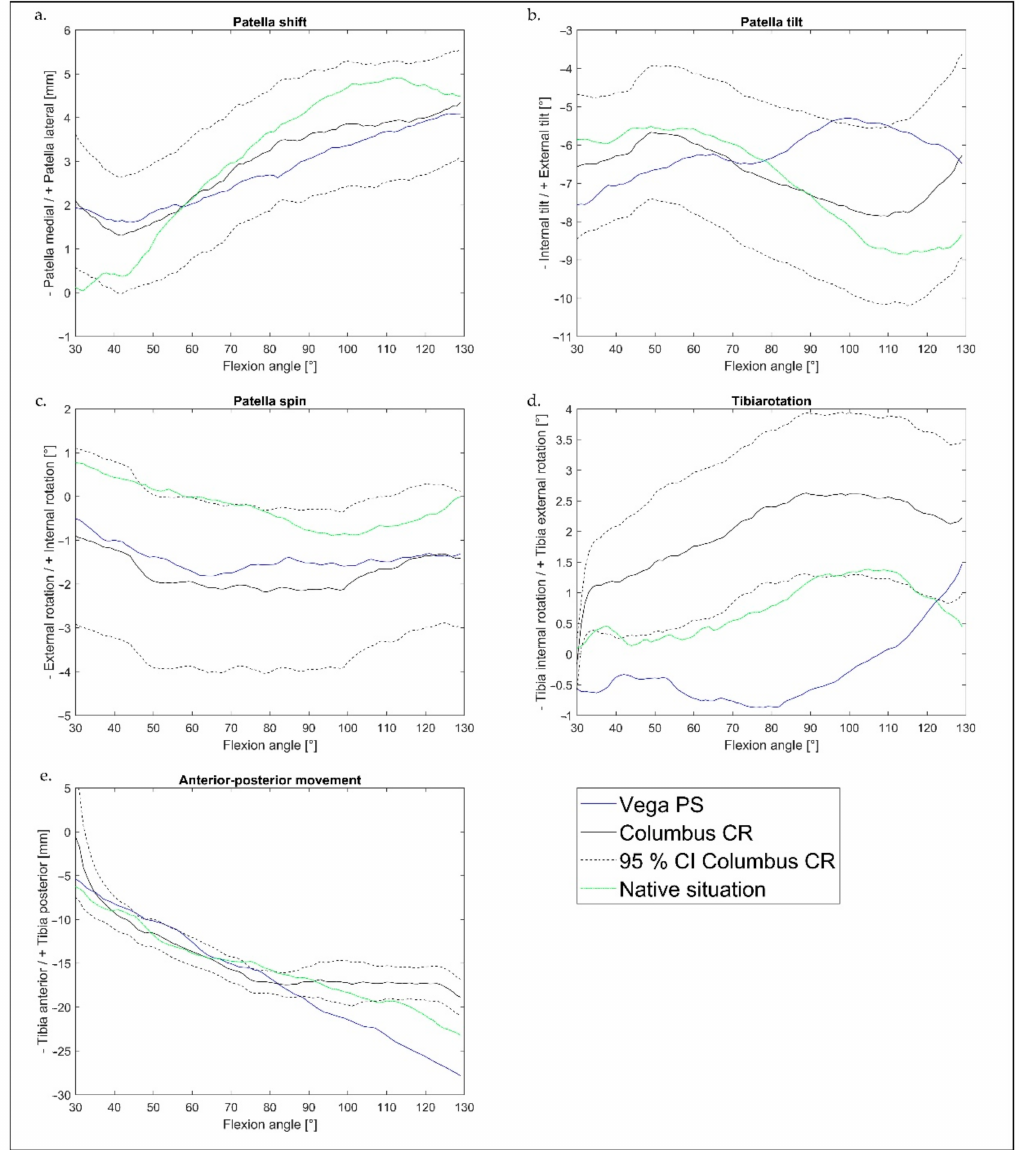
Figure 3. Mean kinematics of all specimens ( n = 8) for the knee flexion angle (30 ◦ − 130 ◦ ): ( a ) patella shift, ( b ) patella tilt, ( c ) patella spin, ( d ) tibia rotation, and ( e ) anterior–posterior movement of tibia of Vega PS (blue), Columbus CR (black), 95% CI of Columbus CR (black dashed), and native situation